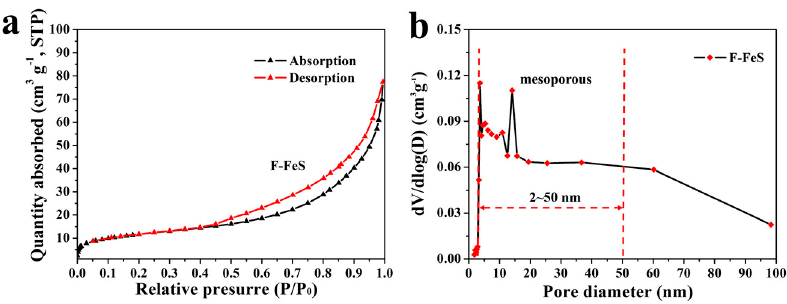
Figure 4. ( a ) Nitrogen adsorption–desorption isotherms and ( b ) pore size distribution curve of 3D F-FeS.